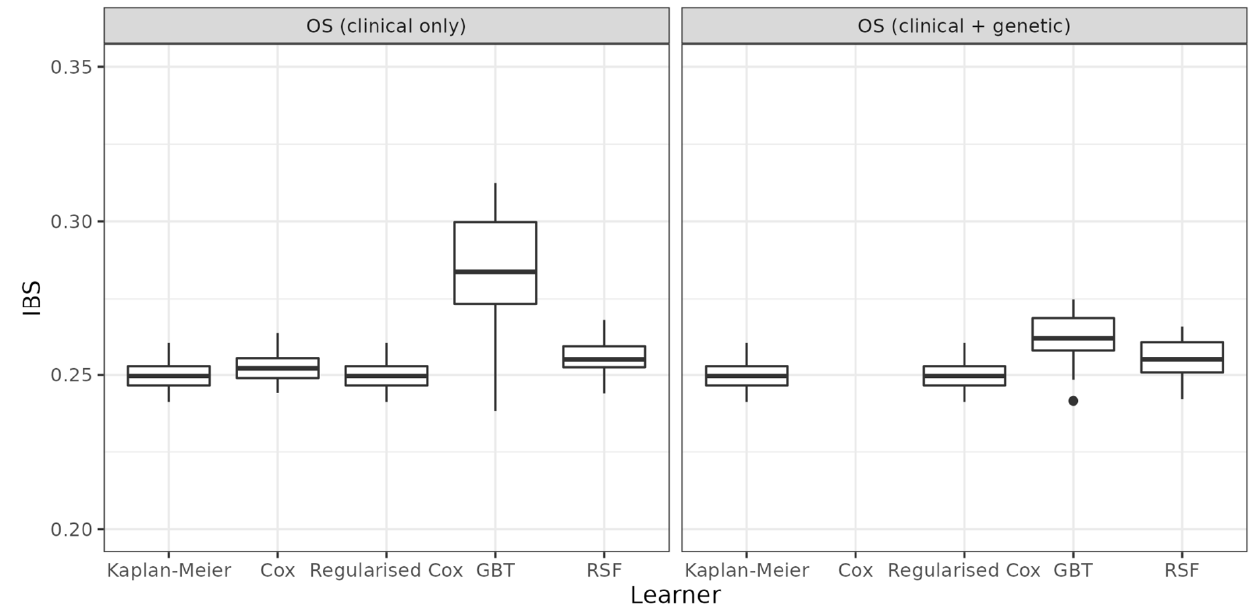
Figure 1. Benchmark experiments with respect to overall survival. Predictive performance of five learners based on 25 values of the IBS. Lower values indicate better performance. Performance based on clinical data only ( left ) is compared to performance based on clinical and gene data ( right ). Performance of the unregularised Cox model is omitted for the high-dimensional setting (data with genes).